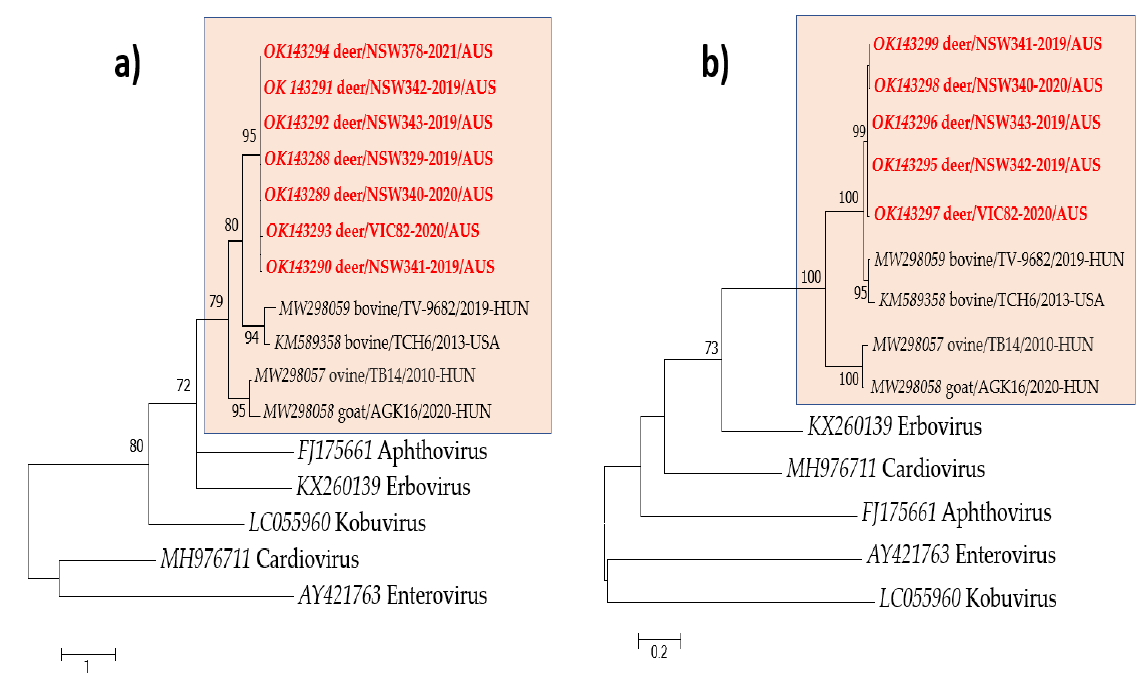
Figure 4. Phylogenetic analyses of deer/bopivirus (in red) and representative members of family Picornaviridae based on partial VP1 ( a ) and 3D ( b ) aa sequences. A highlighted box denotes members of the genus Bopivirus . The trees were generated by the maximum-likelihood method based on JTT + G ( a ) and LG + G ( b ) substitution model with 1000 bootstrap replicates, and the statistics values > 70% are displayed above the tree branches. The scale bar indicates amino acid substitutions per site.